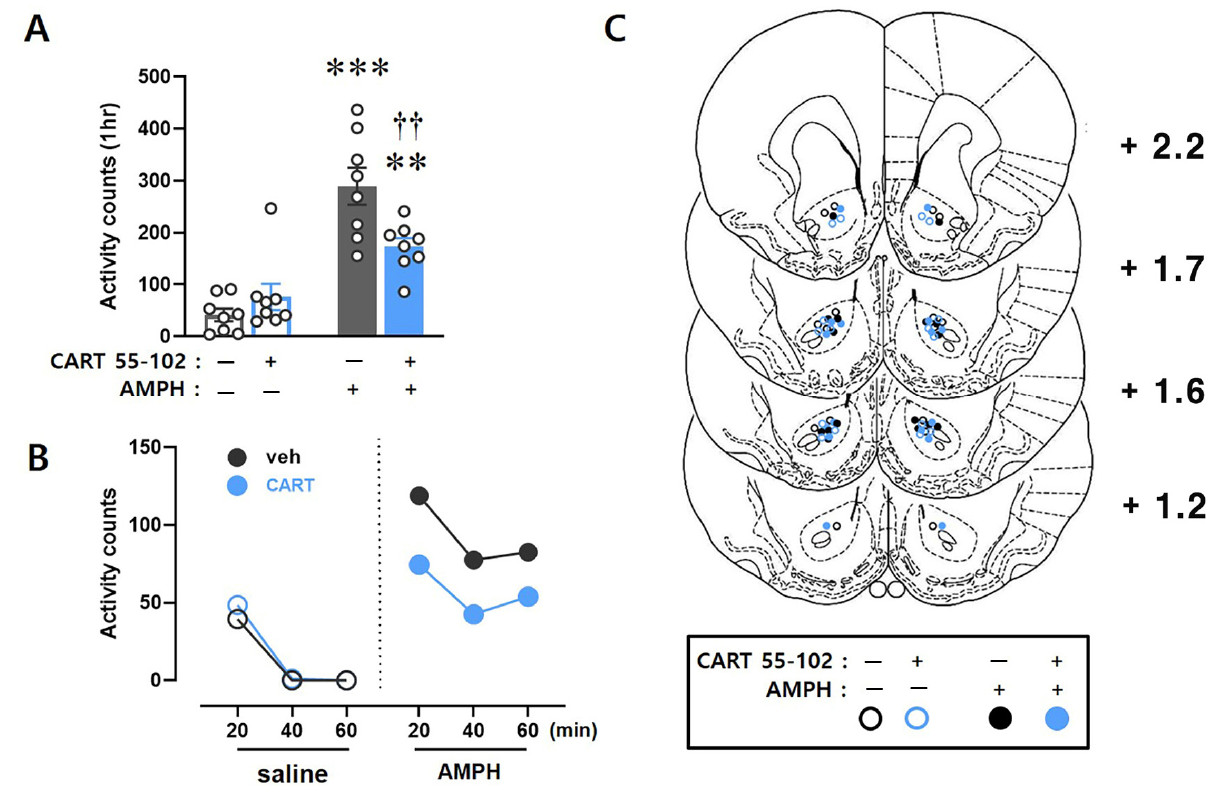
Figure 1. The increased locomotor activity induced by AMPH is blocked by the microinjection of CART peptide 55–102 into the NAcc core. ( A ) Data are shown as group mean (+S.E.M.) total locomotor activity counts observed during the 1 h test after bilateral microinjection of saline or CART peptide 55–102 (2.5 µ g/0.5 µ L/side) into the NAcc core immediately followed by saline or AMPH (1 mg/kg) IP injection. Symbols indicate significant differences revealed by post hoc Tukey comparisons following two-way ANOVA. ** p < 0.01, *** p < 0.001, significantly more counts in AMPH compared to saline IP injection. †† p < 0.01, significant differences between AMPH IP injections. The number of rats in each group is 8. ( B ) Time-course data are shown as group mean locomotor activity counts at 20 min intervals obtained during the 1 h following microinjection (saline or CART 55–102) + IP (saline or AMPH) injection. ( C ) Location of the injection cannula tips. All rats included in the data analyses had injection cannula tips located bilaterally in the NAcc core. The line drawings are adapted with permission from Paxinos and Watson [40]. Numbers to the right indicate millimeters from bregma.